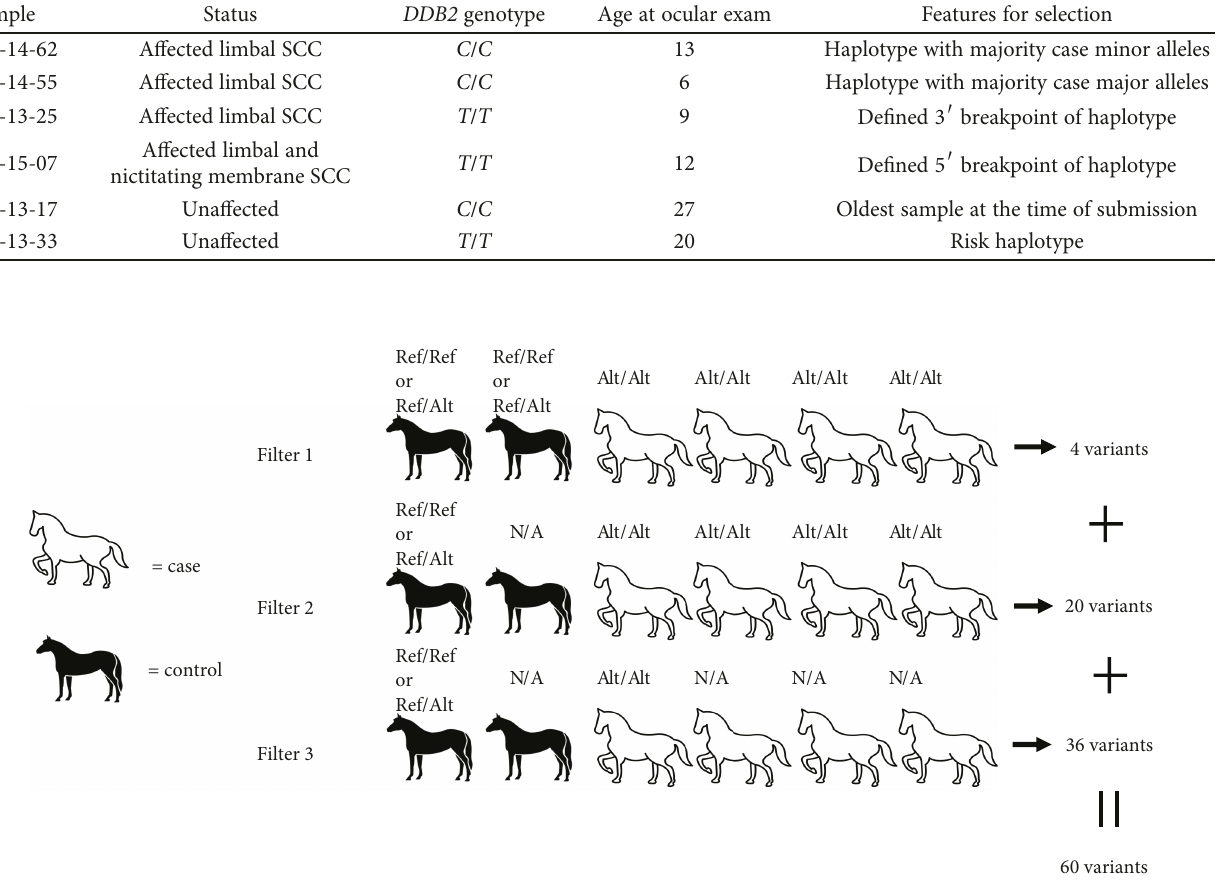
Figure 1: Filtering of variants from high-throughput Illumina sequencing analysis of six Ha fl ingers phenotyped for ocular SCC. These fi ltering parameters were established for the most robust analysis to identify any potential variant from the associated ECA12 haplotype that may explain the prevalence for ocular SCC in Ha fl inger horses. Filter 1 was used to categorize variants based on the strictest parameters in order to identify variants more concordant with the ocular SCC phenotype than the DDB2 variant. Filter 2 used slightly less strict fi ltering of variants by allowing one of the control horses to genotype homozygous alternate for that variant. Lastly, fi lter 3 used the least stringent fi ltering by allowing for one or more a ff ected horses to genotype as homozygous reference or heterozygous for that variant. On the diagram, N/A signi fi es any